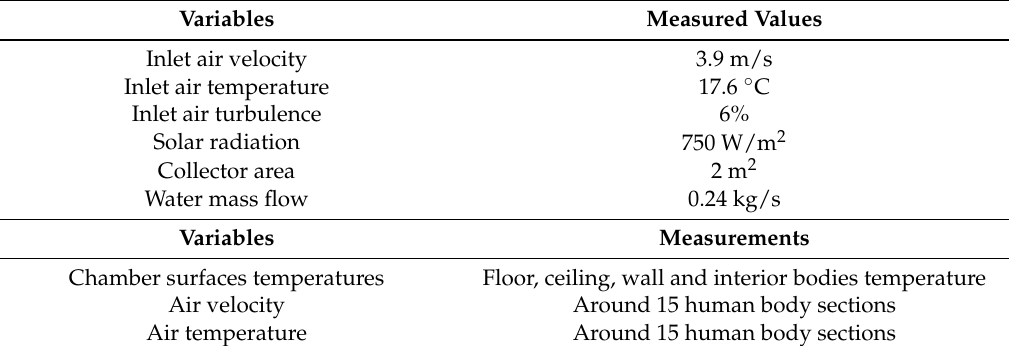
Table 1. Inlet model variables obtained in the experimental tests and used in the numerical